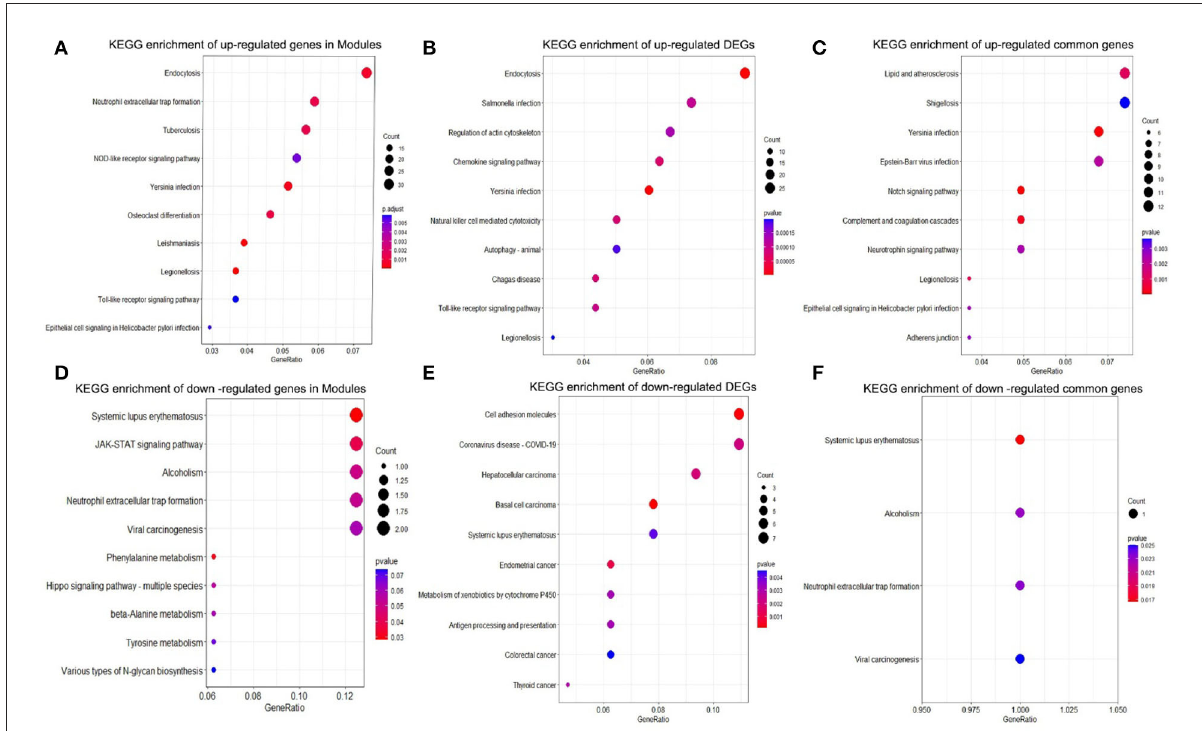
FIGURE4 KEGG pathway enrichment analysis. (A) Top 10 KEGG pathway enrichment results of upregulated genes in the modules. (B) Top 10 KEGG pathway enrichment results of upregulated DEGs. (C) Top 10 KEGG pathway enrichment results of upregulated common genes. (D) Top 10 KEGG pathway enrichment results of downregulated genes in the modules. (E) Top 10 KEGG pathway enrichment results of downregulated DEGs. (F) KEGG pathway enrichment results in downregulated common genes. KEGG, Kyoto encyclopedia of genes and genomes; DEGs, differentially expressed